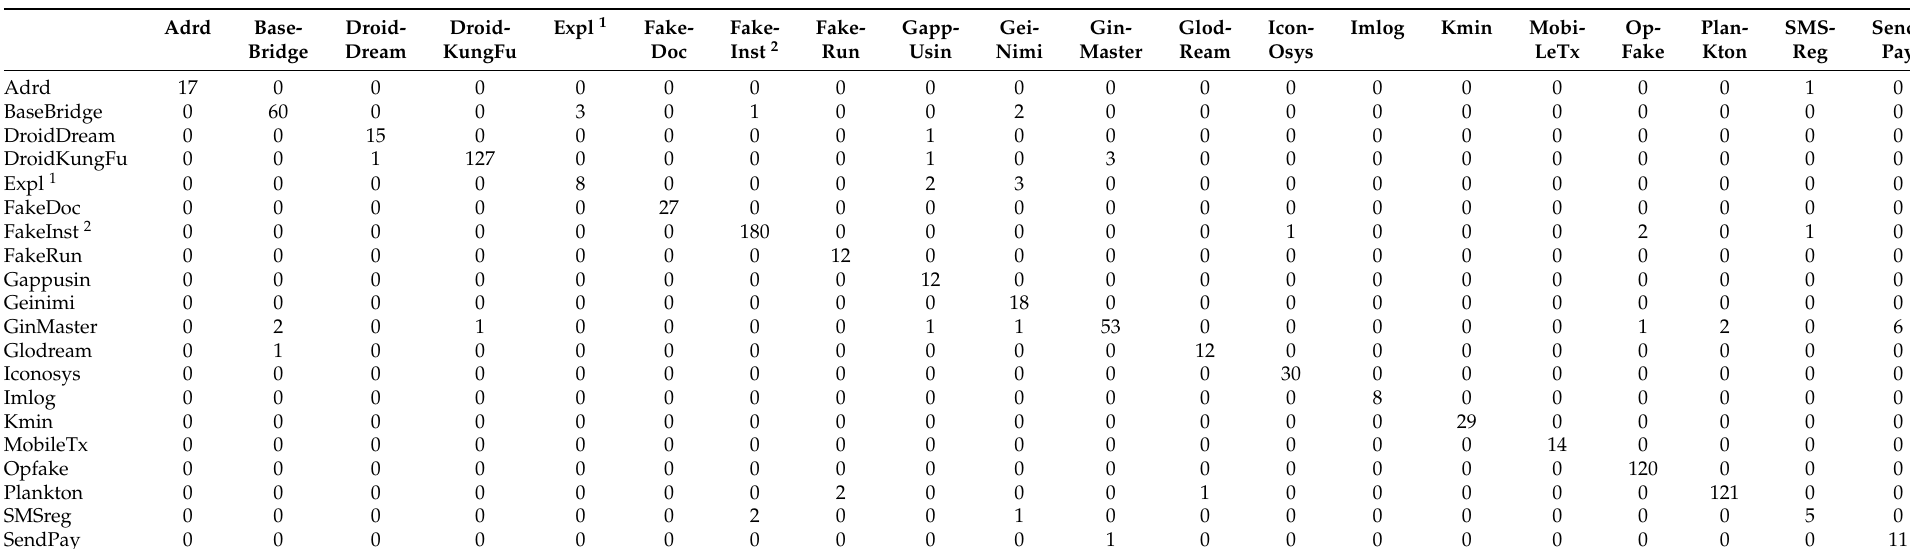
Table A5. Confusion matrix of LightGBM with